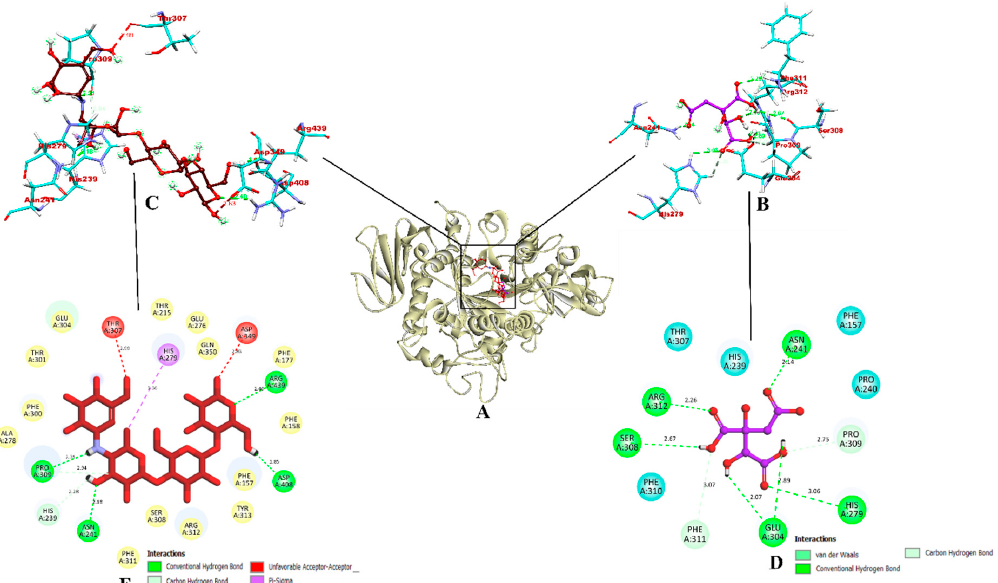
Figure 8. The binding interactions of hydroxyacetic acid and acarbose within the inhibitor binding site of target protein α -glucosidase. ( A ) Ribbon representation of a protein model bound with the ligands (inside the binding site); ( B , C ) Three-dimensional binding pa tt ern of hydroxyacetic acid and acarbose, respectively. ( D , E ) Two-dimensional binding pa tt ern of hydroxyacetic acid and acarbose, respectively. Red: acarbose; purple: hydroxyacetic acid. Blue and yellow: surrounding residues; colored: bound residues.